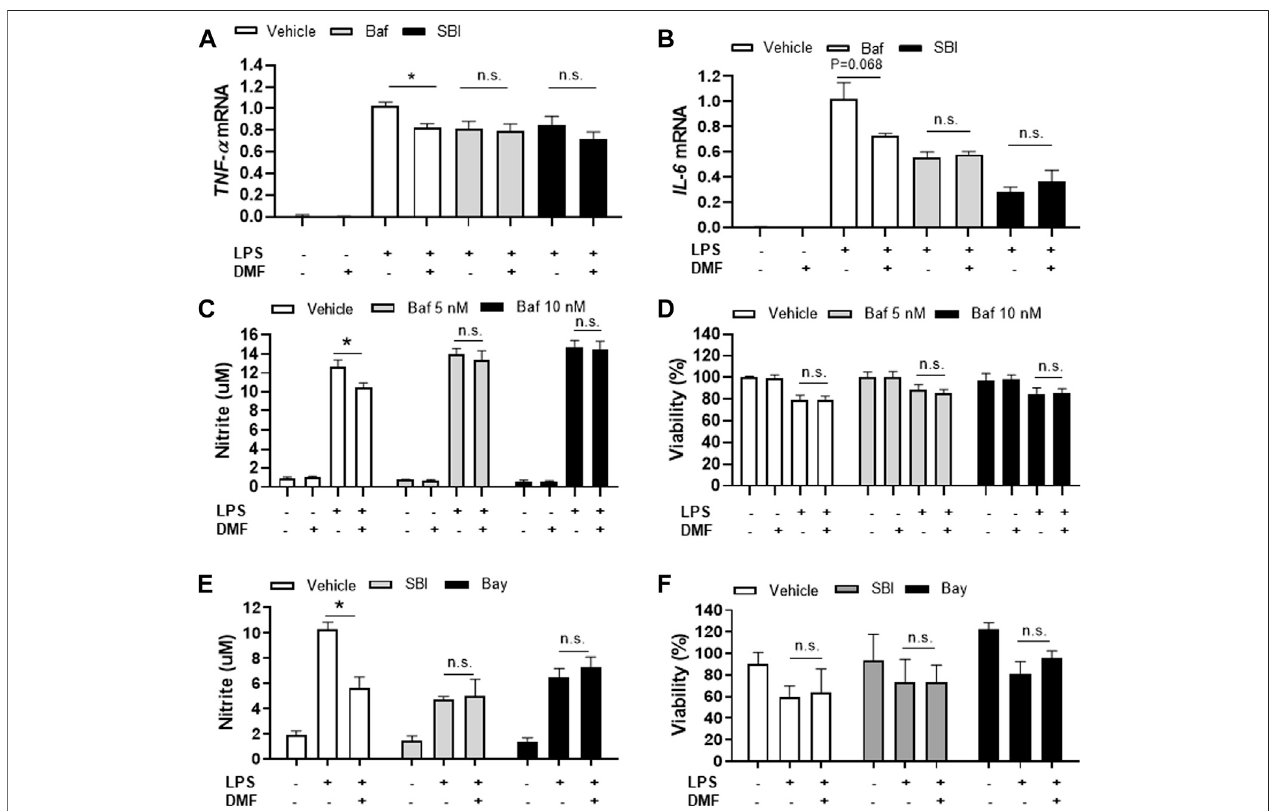
FIGURE 5 | DMF induces anti-in fl ammatory responses in MGC via an autophagy-dependent pathway (A, B) MGC were seeded at 2 × 10 5 cells/well in a 12-well plate and incubated overnight. Cells were then pretreated with ba fi lomycin (10 nM, Baf) or SBI-0206965 (5 μ M, SBI) for 1 h, followed by treatment with DMF (4 μ M) and LPS (1 μ g/ml). After 6 h, the mRNA expression levels of TNF- α (A) and IL-6 mRNA (B) were measured by RT-qPCR. Fold changes were calculated as the ratio of expression level in LPS-treated cells (C, D) MGC were seeded at 3 × 10 4 cells/well in a 96-well plate and incubated overnight. Cells were then pretreated with ba fi lomycin(5(gray)or10 (black)nM)for1 h,followedbytheadditionofDMF(4 μ M)andLPS(1 μ g/ml).After48 h,NOproductionwasmeasuredbytheGriessassay (C) andcellviabilitywasmeasuredbytheMTTassay (D)(E,F) MGCwereseededat3 × 10 4 cells/wellina96-wellplateandincubated overnight.Cellswerethenpretreated withSBI-0206965(5 μ M,gray)orBay11 – 7082(2.5 μ M,Bay,black)for1 h,followedbytreatmentwithDMF(4 μ M)andLPS(1 μ g/ml).After48 h,NOproduction (E) and cell viability (F) were measured. n (cid:2) 3 independent experiments/group. Data are presented as means ± SEM. * P < 0.05 compared with LPS treated group, n.s., not signi fi cant ( P >